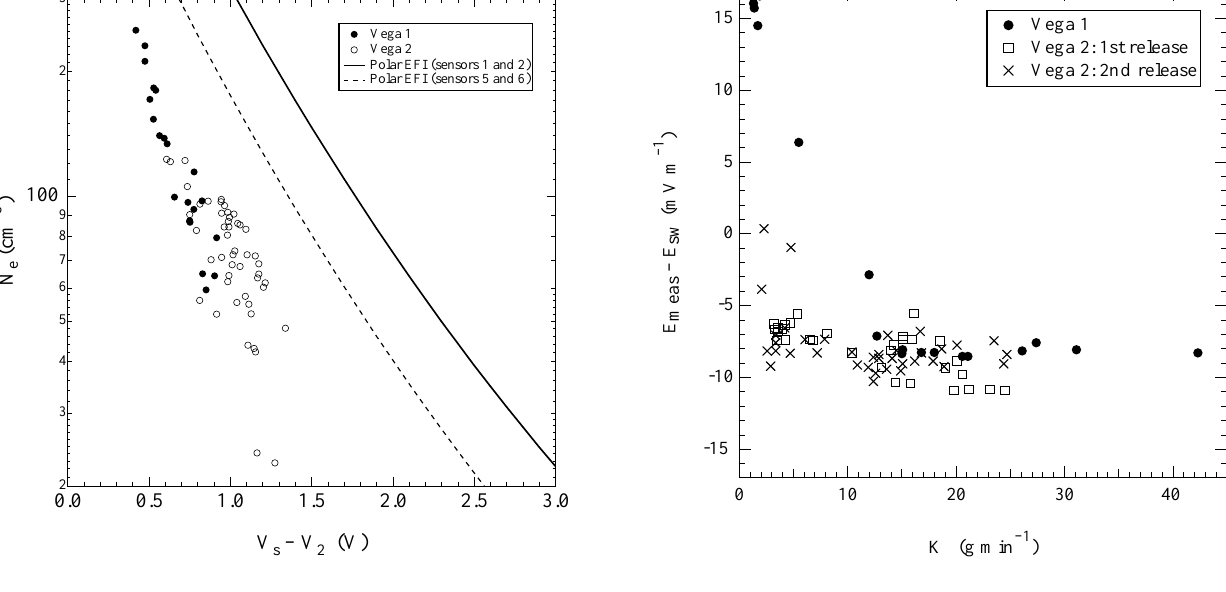
Fig. 9. Quasistatic electric field E y plotted against the gas release rates for Vega 1 and Vega